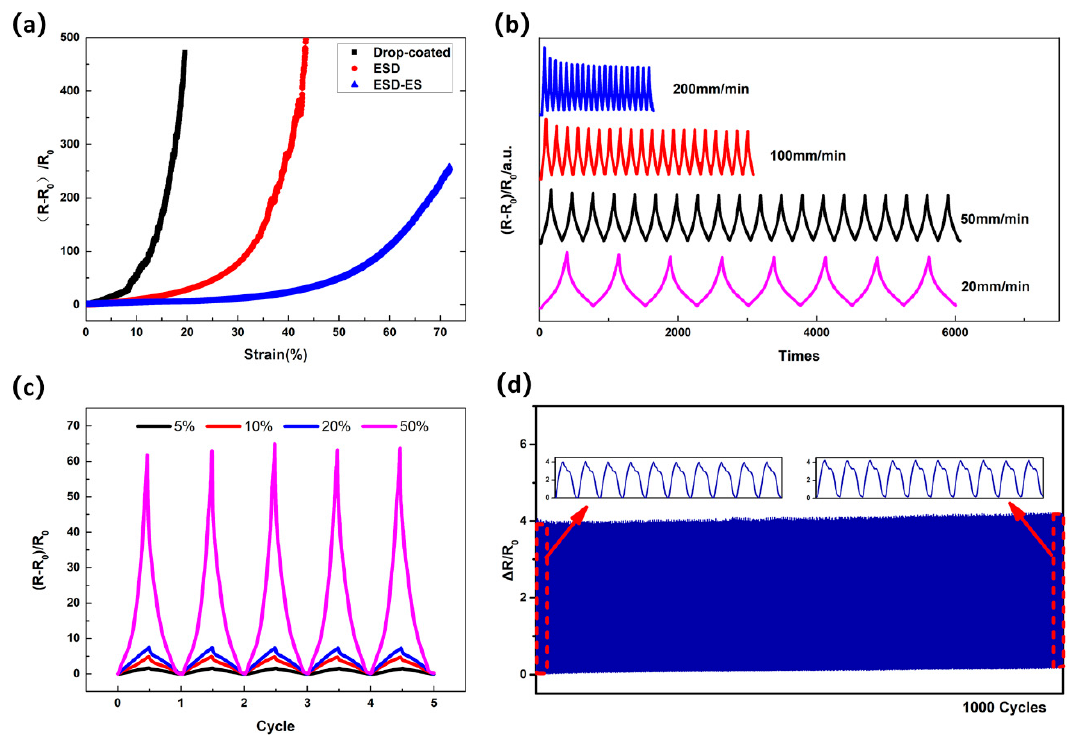
Figure 4. ( a ) The basic characteristics of the strain sensors. The relative resistance change versus the applied strain of up to 100%. Drop coated represents the characteristics of sensor with drop coated sensing layer; ESD represents the characteristics of sensor with ESD sensing layer but without sandwich structure of the electrospun encapsulation; ESD-ES represents the characteristics of sensor with ESD sensing layer with sandwich structure of the electrospun encapsulation. ( b ) the relative resistance variation of ESD-ES sensor with a strain of 30% at different strain rates; ( c ) the relative resistance change of ESD-ES sensor with various cyclic strains at a strain rate of 10 mm min − 1 ; ( d ) the performance of the ESD-ES sensor under cyclic tensile loading for 1000